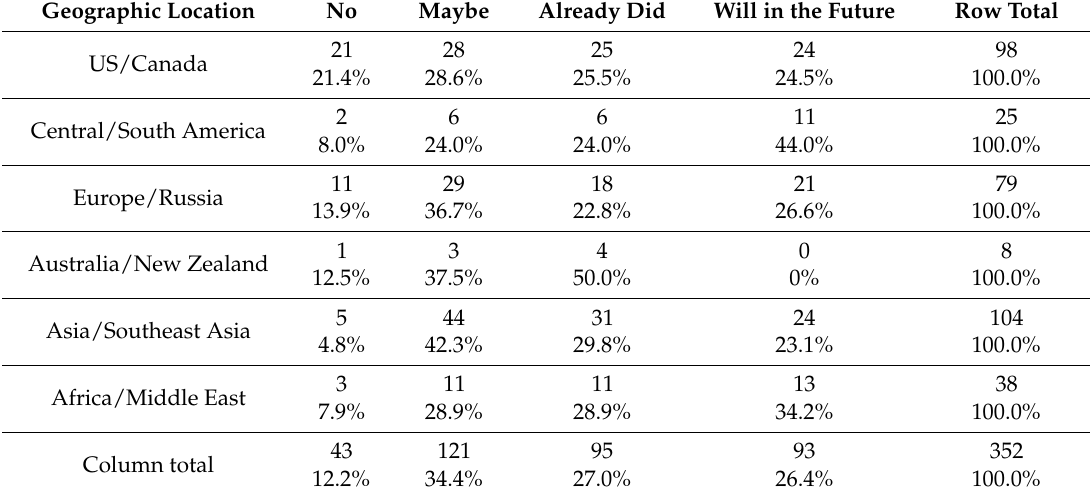
Table 30. Citation of article readings by geographic